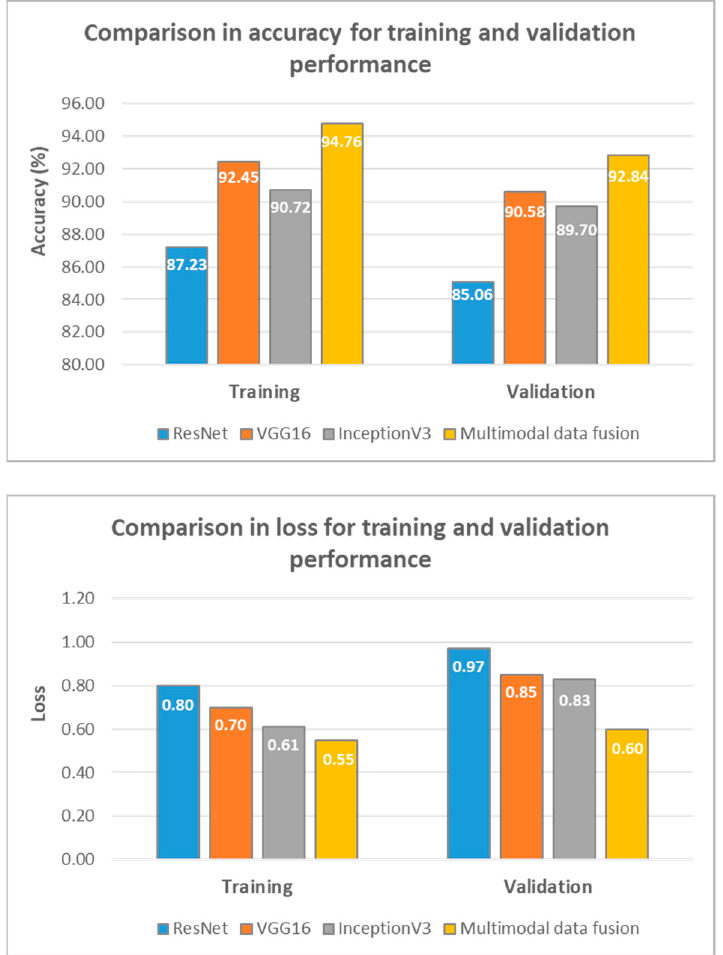
Figure 3. Comparison in accuracy and loss for the training and validation performance of deep learning models. learning